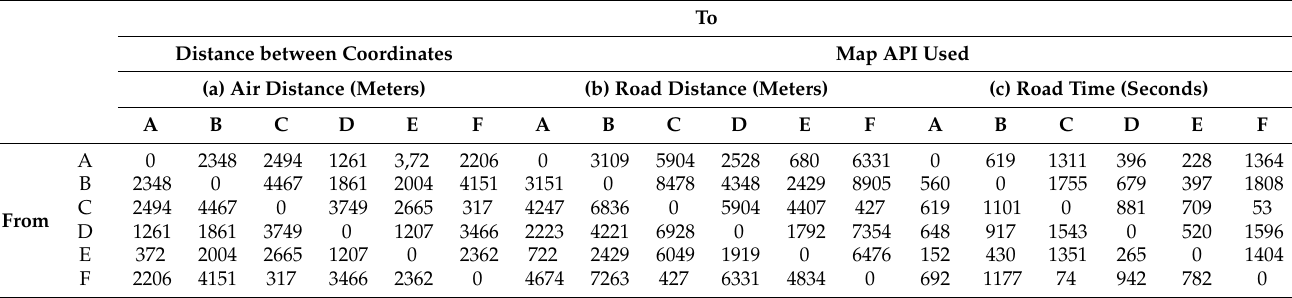
Table 1. Cost matrix examples: ( a ) Air distance; ( b ) road distance; ( c ) road time. To Distance between Coordinates Map API